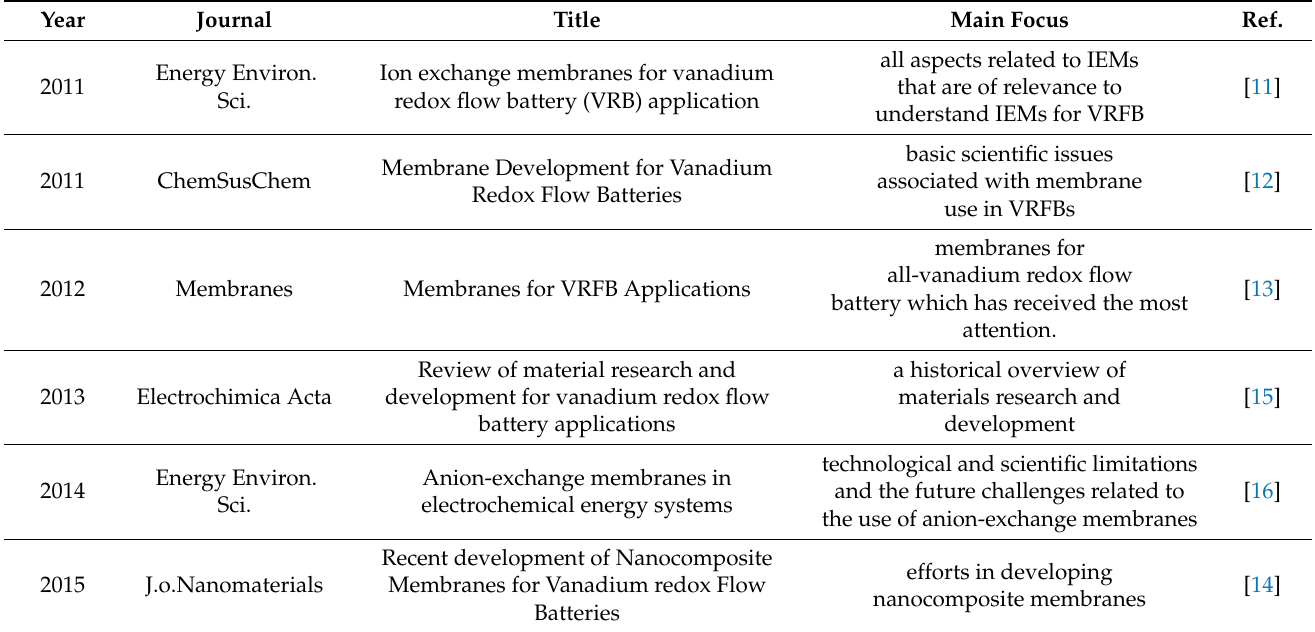
Table 1. Overview of review papers considering vanadium redox flow battery membranes. Title Main Focus